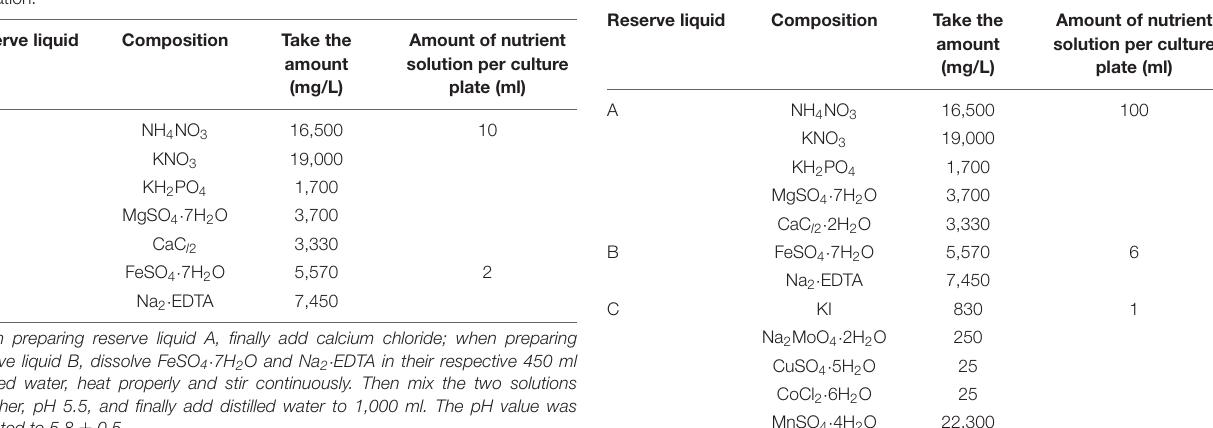
TABLE 2 | Preparation of nutrient solution for inducing root primitive body formation. Reserve liquid